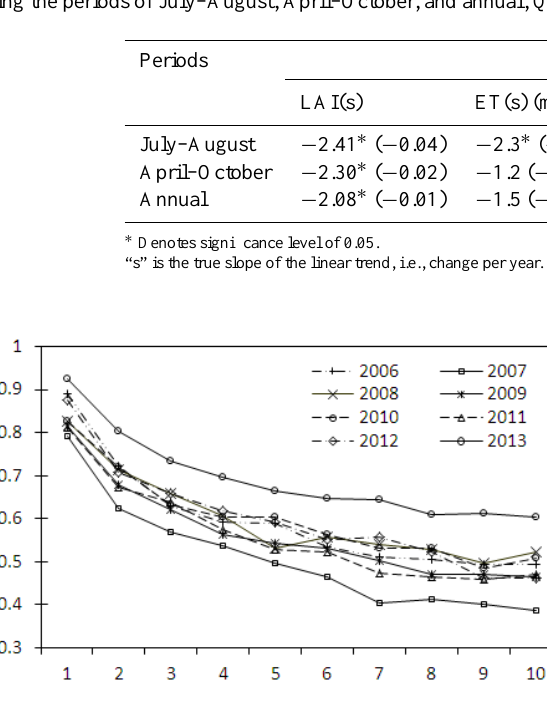
Table 3. Summary of Z statistics by the Nonparametric Mann-Kendall trend tests for temperature ( T ), ET, PET, precipitation ( P ), and LAI during the periods of July–August, April–October, and annual, Qinhuai River basin (2000–2013).